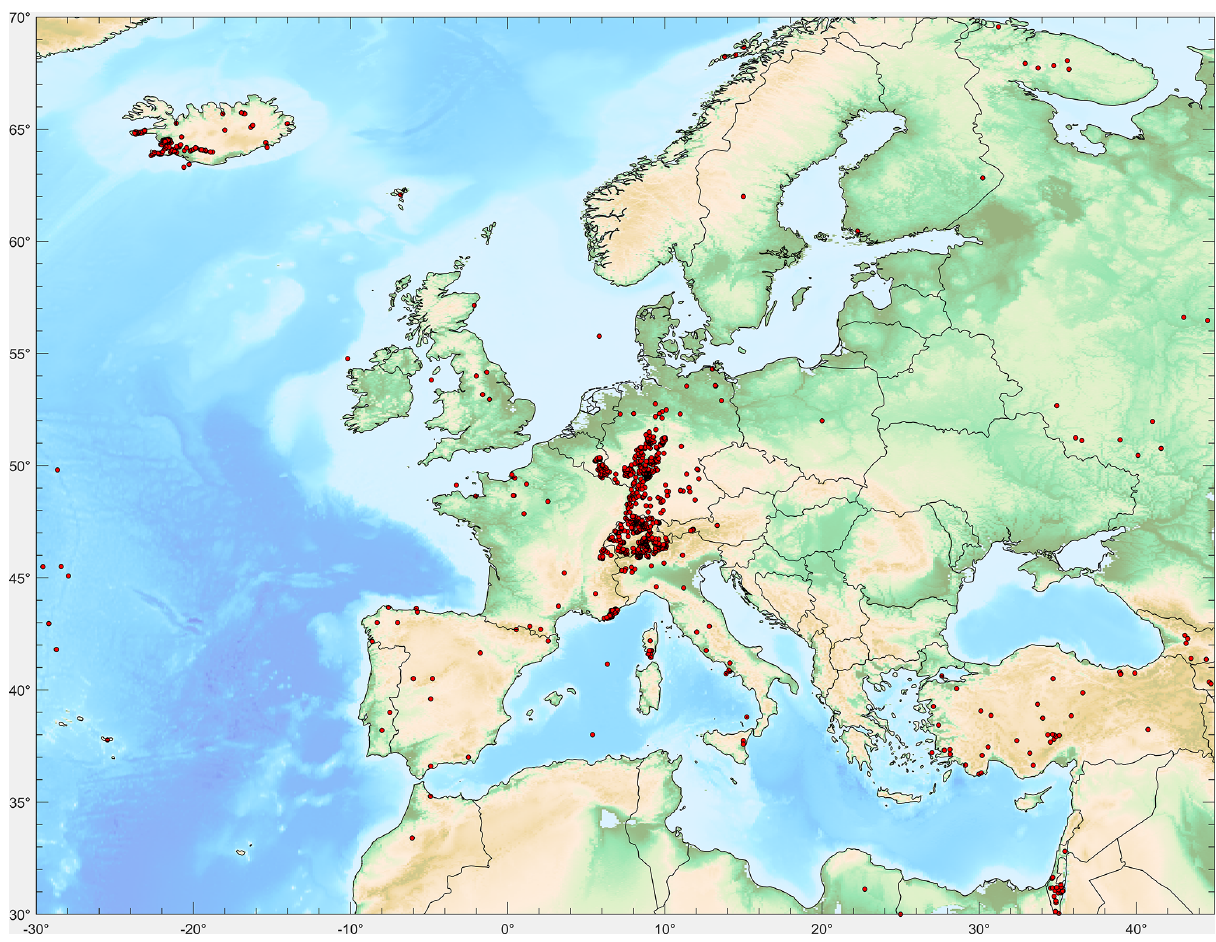
Figure 5. Locations of data points currently included in P 3 for Europe (for references see Appendix A). Topographic map is the ETOPO1 map (Amante and Eakins, 2009).